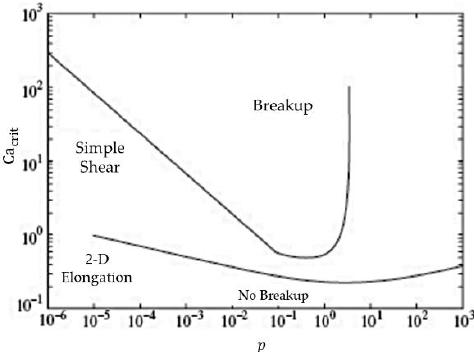
Figure 1. Capillary number Ca vs viscous ratio p [23].